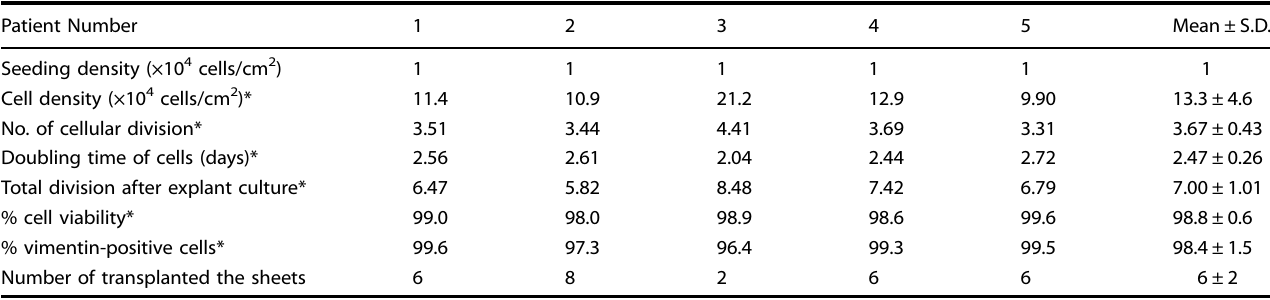
Table 4. The results of fabrication of dermal fi broblast sheets. Patient